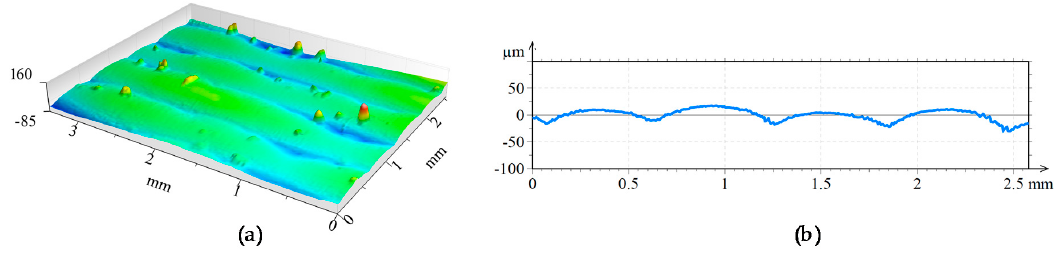
Figure 9. ( a ) Topography and ( b ) surface profile LMD.